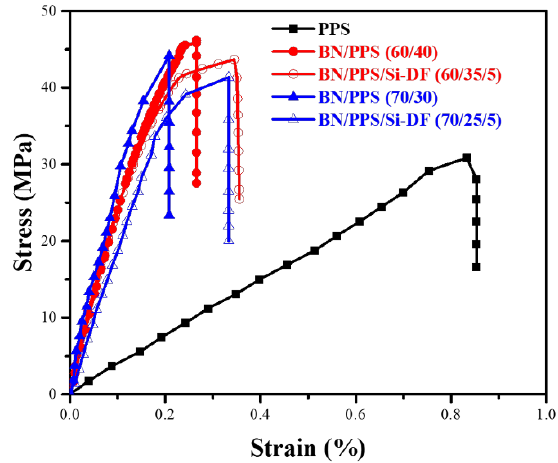
Figure 8. Strain–stress curves of PPS matrix and BN/PPS Figure 8. Strain – stress curves of PPS matrix and BN/PPS composites.